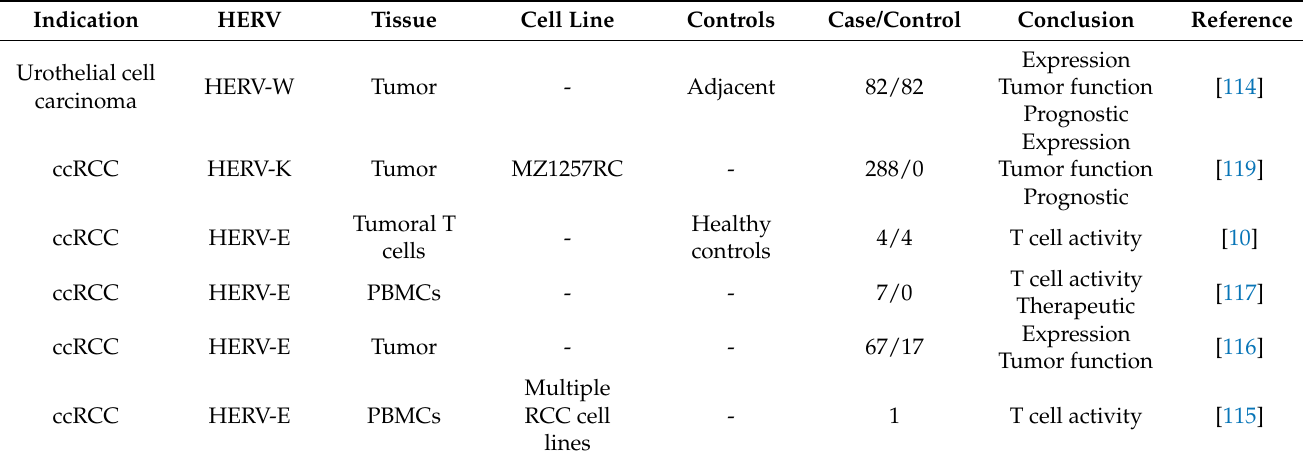
Table 9. HERV protein expression in urological cancers.